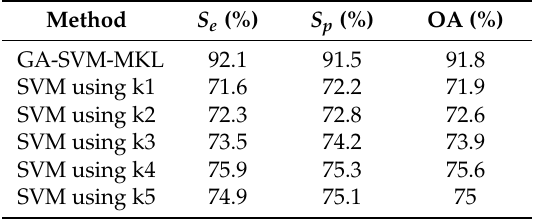
Table 2. Comparisons between Proposed and Traditional SVM